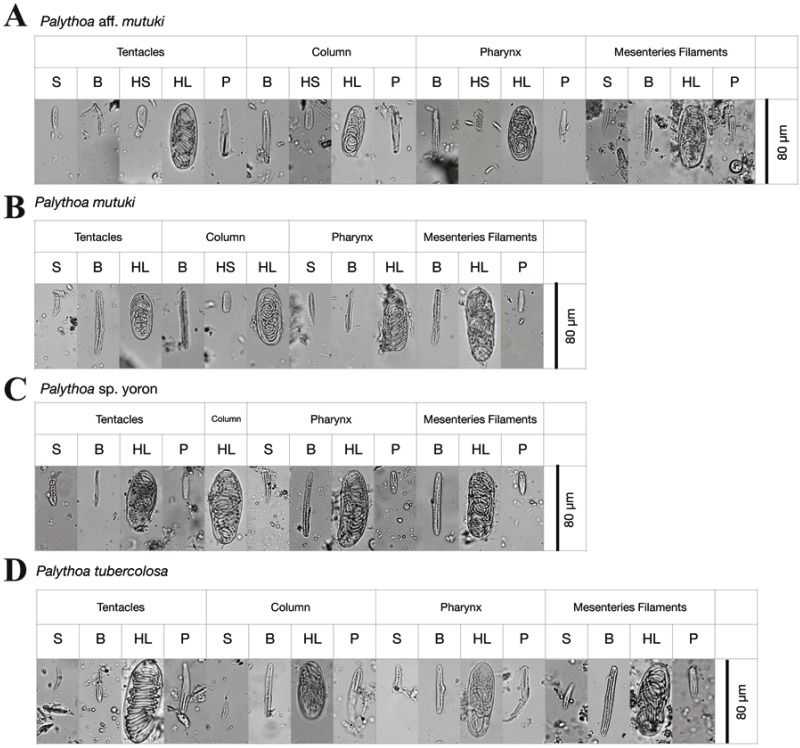
Cnidae of Palythoa species examined in this study.Cnidae in tentacles, column, pharynx, and filaments of (A) Palythoa aff. mutuki, (B) Palythoa mutuki, (C) Palythoa sp. yoron, and (D) Palythoa tuberculosa. S, spirocysts; B, basitrichs; HS, holotrichs small; HL, holotrichs large; P, microbasic p-mastigophores.